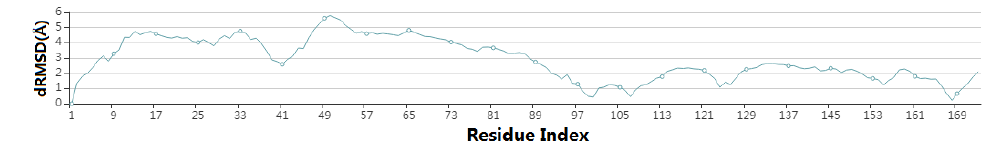
Figure 8. The line chart shows the change in dRMSD during the assessment stage of the